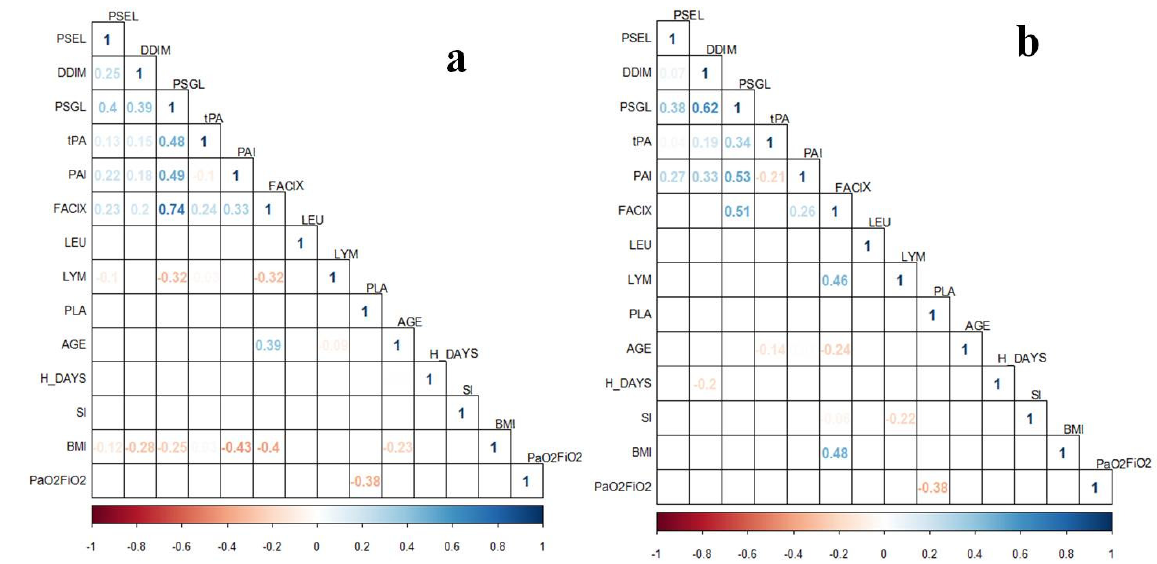
Figure 3. Correlation plots of coagulation proteins’ levels from the two-time determination subgroup ( n = 35) with clinical variables in patients with COVID-19. ( a ) Coagulation proteins correspond to the delta values assessed (Time 1–Time 2); ( b ) Coagulation proteins’ levels from the second determination (Time 2). Correlations were assessed with Spearman Correlation Test. Only ρ values statistically significant ( p < 0.05) are shown in the plots. BMI, body mass index; FACIX, Factor IX; DDIM, D-dimer; H_DAYS, hospitalization days; LEU, leukocytes; LYM, lymphocytes; PAI, plasminogen activator